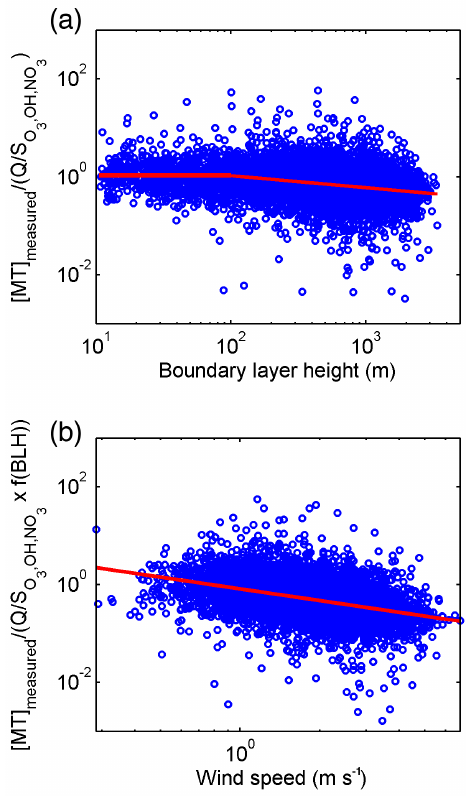
Figure 1. The ratio between the measured monoterpene concentra- tion and the initial version of MT proxy , ideal (a) as the function of boundary layer height, (b) as the function of wind speed after the dependence on the boundary layer height has already been included. The red lines show the fitted